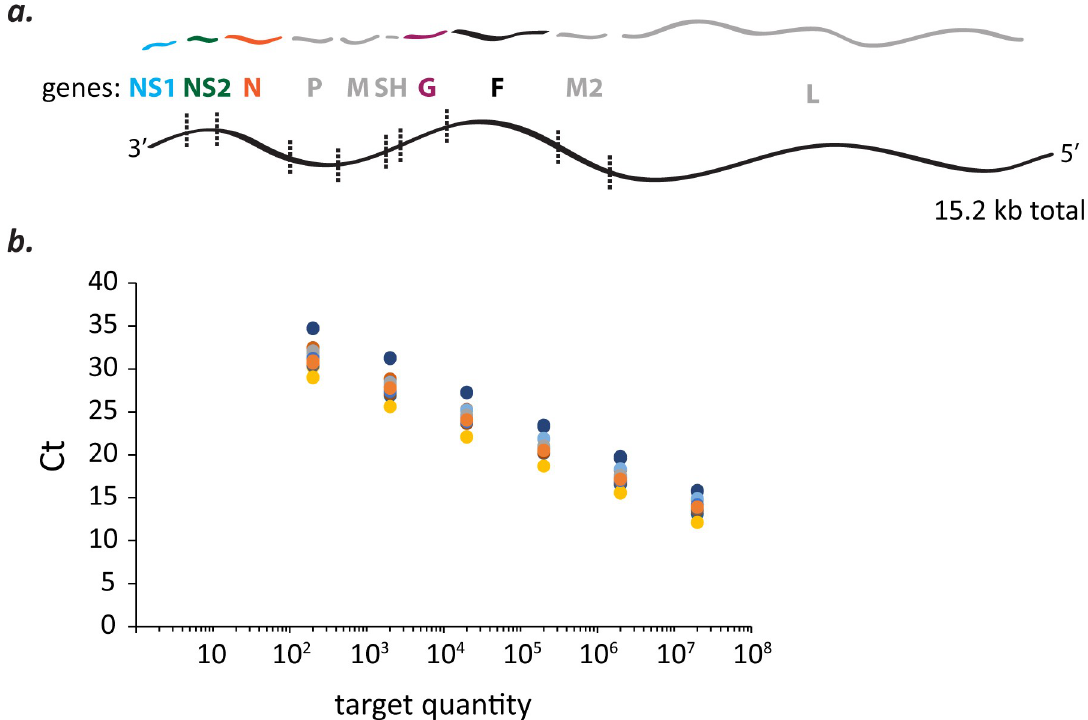
Fig 1. qPCR-based measurements of mRNA abundances for five RSV genes from four isolates representing different genotypes using oligonucleotide standards. (a) Five of 10 RSV genes were chosen for mRNA abundance measurements by qPCR. The 5 genes (NS1, NS2, N, G, & F) span half of the nucleotide length of the 15.2 kb genome and its entire gene length minus the final two genes, M2 and L. (b) Known amounts of different oligonucleotide standards were detected over a similar range of cycle threshold ( C T ) values. Twenty different oligonucleotide standards at known concentrations were needed (4 virus isolates x 5 mRNA targets) to convert C T values measured for viral mRNA targets into mRNA abundances. Each dot represents the mean C T of duplicate measurements of an oligonucleotide standard at a known concentration or quantity (= number of molecules / qPCR rxn). Dots of like color are dilutions of the same oligonucleotide standard.